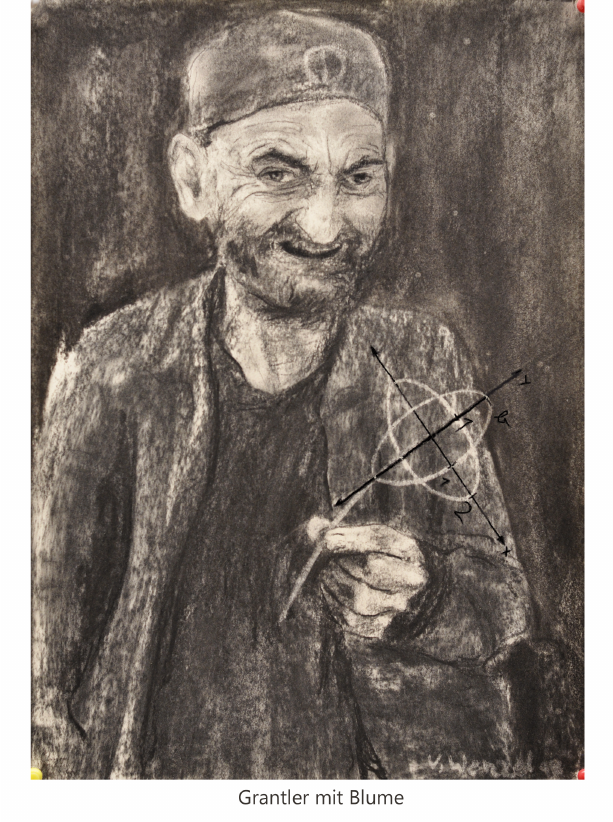
Figure 5. Philosophical reflection of a mathematical phenomenon ( Grantler mit Blume , Charcoal on paper, 42 ×